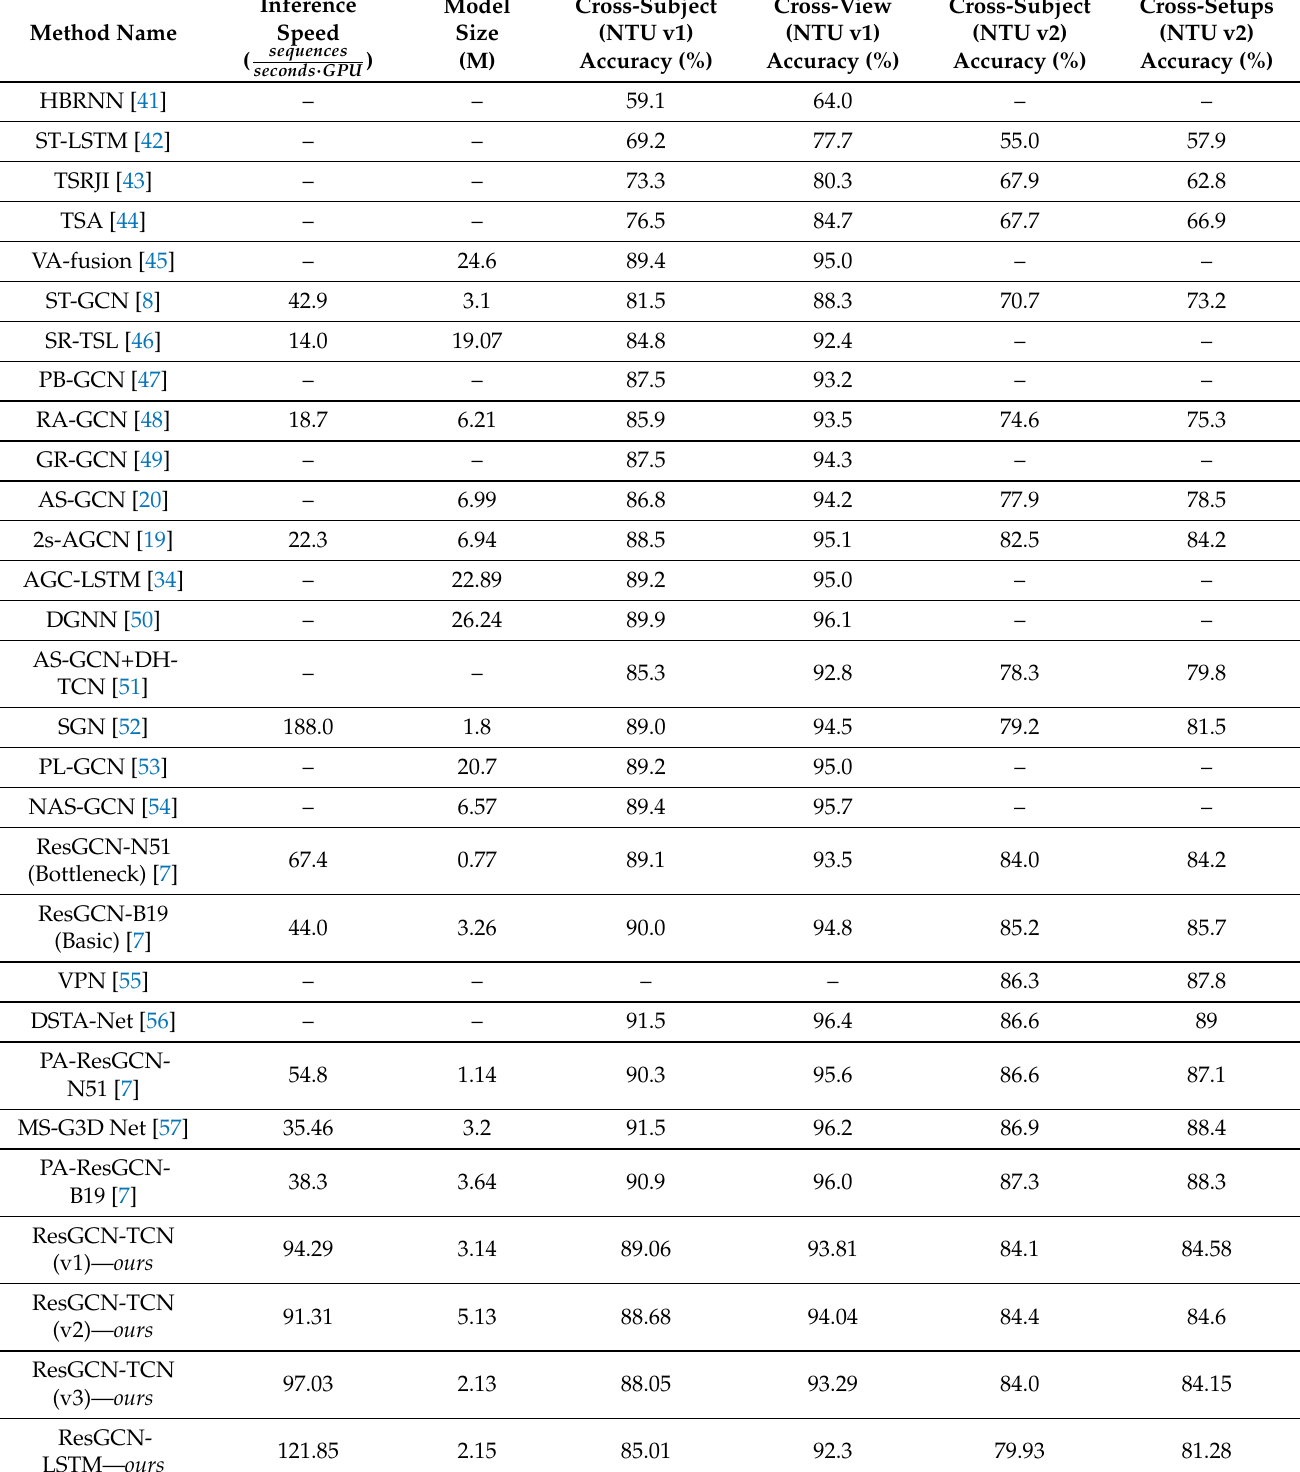
Table 1. Table showing comparative results from the perspective of accuracy for the four test protocols, but also performance related to computability (processing speed and number of